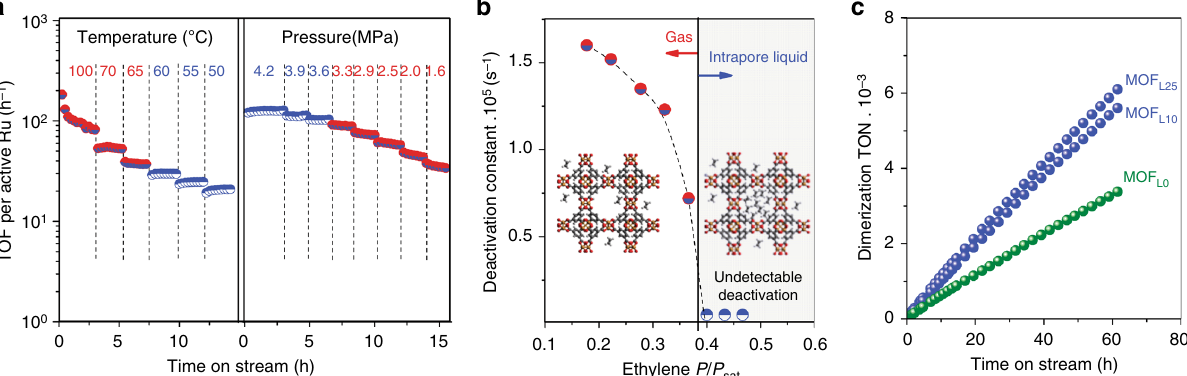
Fig. 5 Stability of MOF catalysts. a Turnover frequencies per active Ru as a function of temperature at 4.2 MPa ethylene and pressure at 50 °C. b First- order deactivation constants, derived from ethylene pressure changes in ( a ), as a function of ethylene relative saturation pressure ( P/P sat ) within MOF L25 . c Long-term stability during ethylene dimerization at 4.2 MPa ethylene and 50 °C for MOF L25 , MOF L10 , and MOF